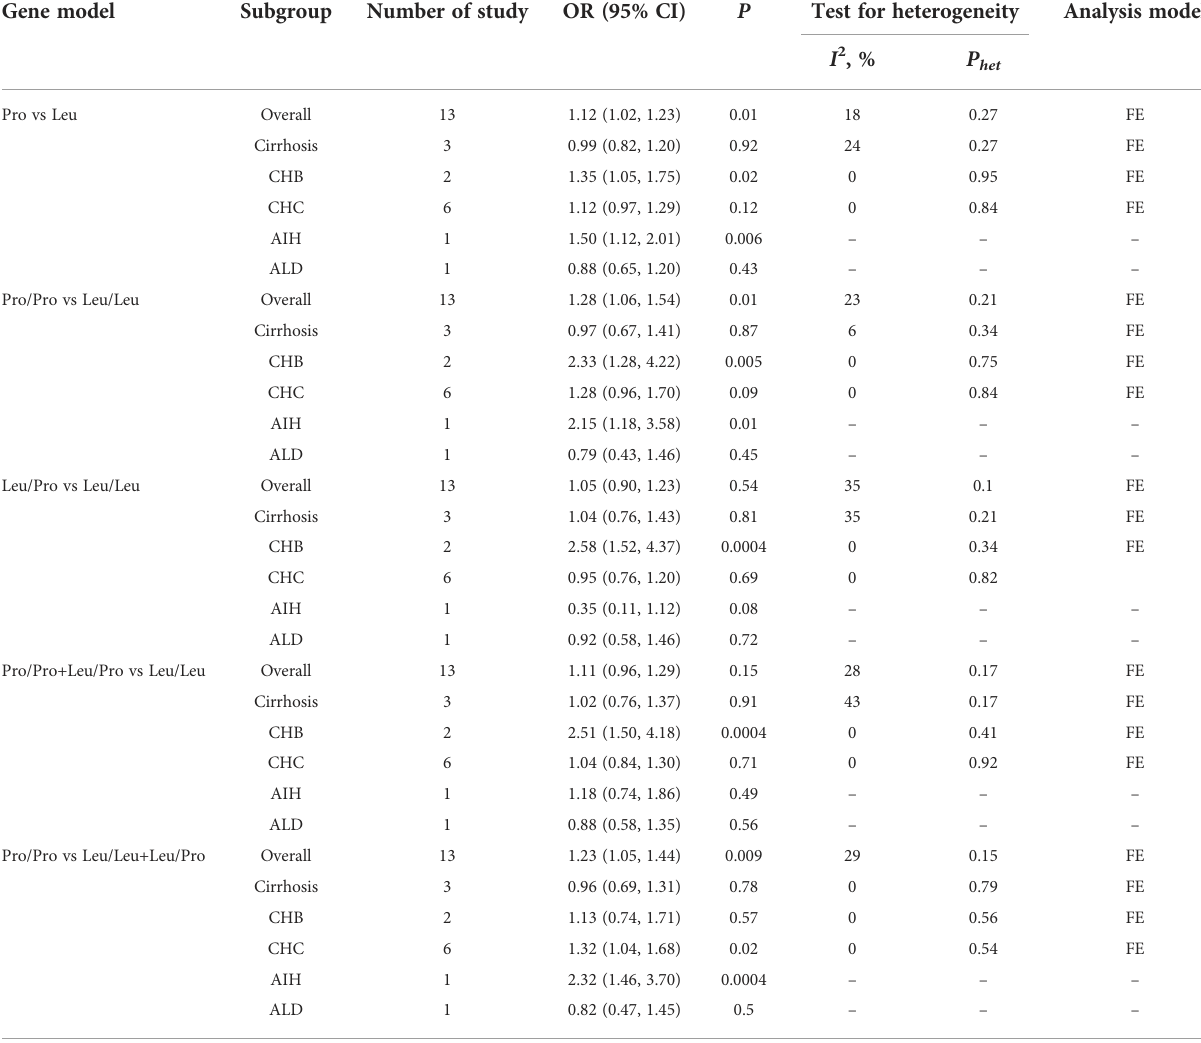
TABLE 7 Subgroups results of the role of TGF- b 1 codon 10 polymorphism in different CLDs. Gene